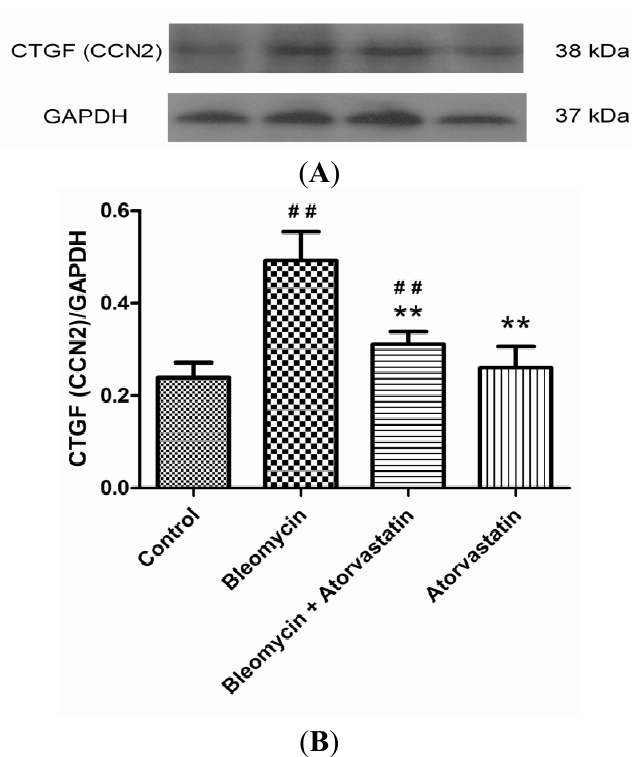
Figure 6. Western blot analysis of CTGF (CCN2) levels in the lungs of bleomycin-induced pulmonary fibrosis rats. The increased levels of CTGF (CCN2) protein expression were obviously suppressed by administration of atorvastatin. ( A ) Representative blots are shown and protein size is expressed in kDa; and ( B ) Densitometric quantification data are expressed as the intensity ratio of target proteins to GAPDH (mean ± SD, n =